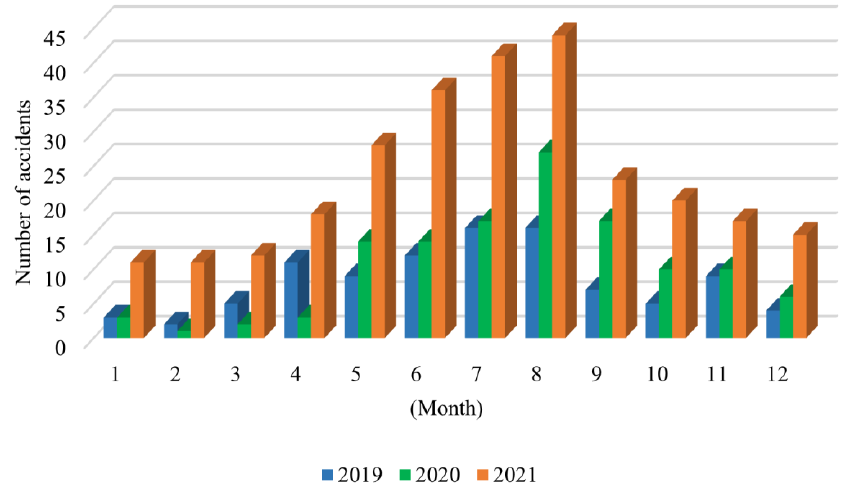
Figure 1. Comparison of EV charging incidents from 2019 to 2021 in China.